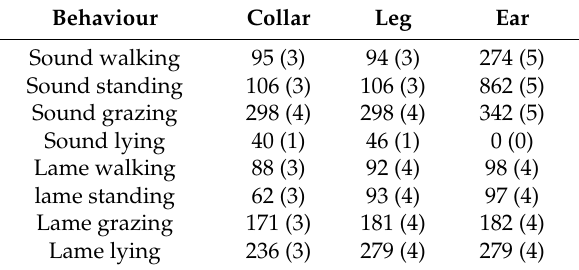
Table 3. Total number of 10 s mutually exclusive behaviour epochs. The number of animals for which behaviours were collected within each deployment is shown in